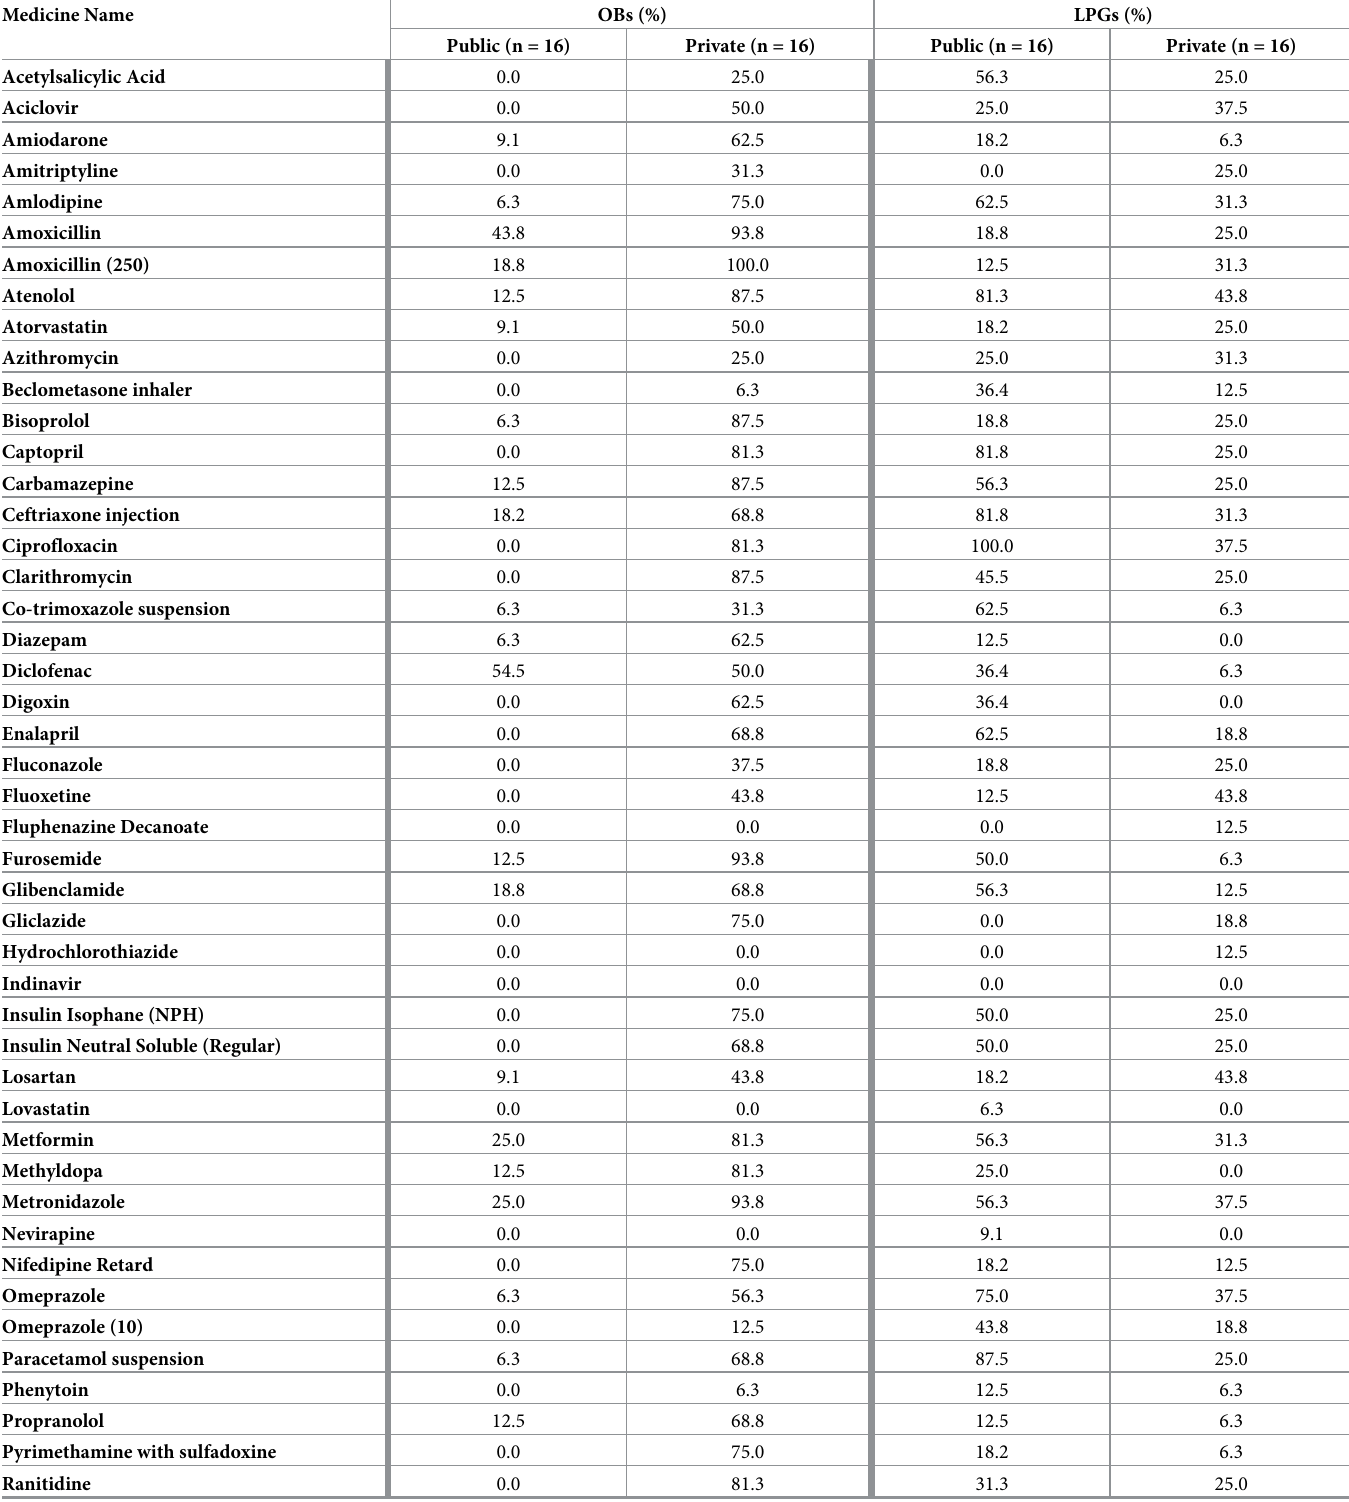
Table 1. Individual medicines availability in